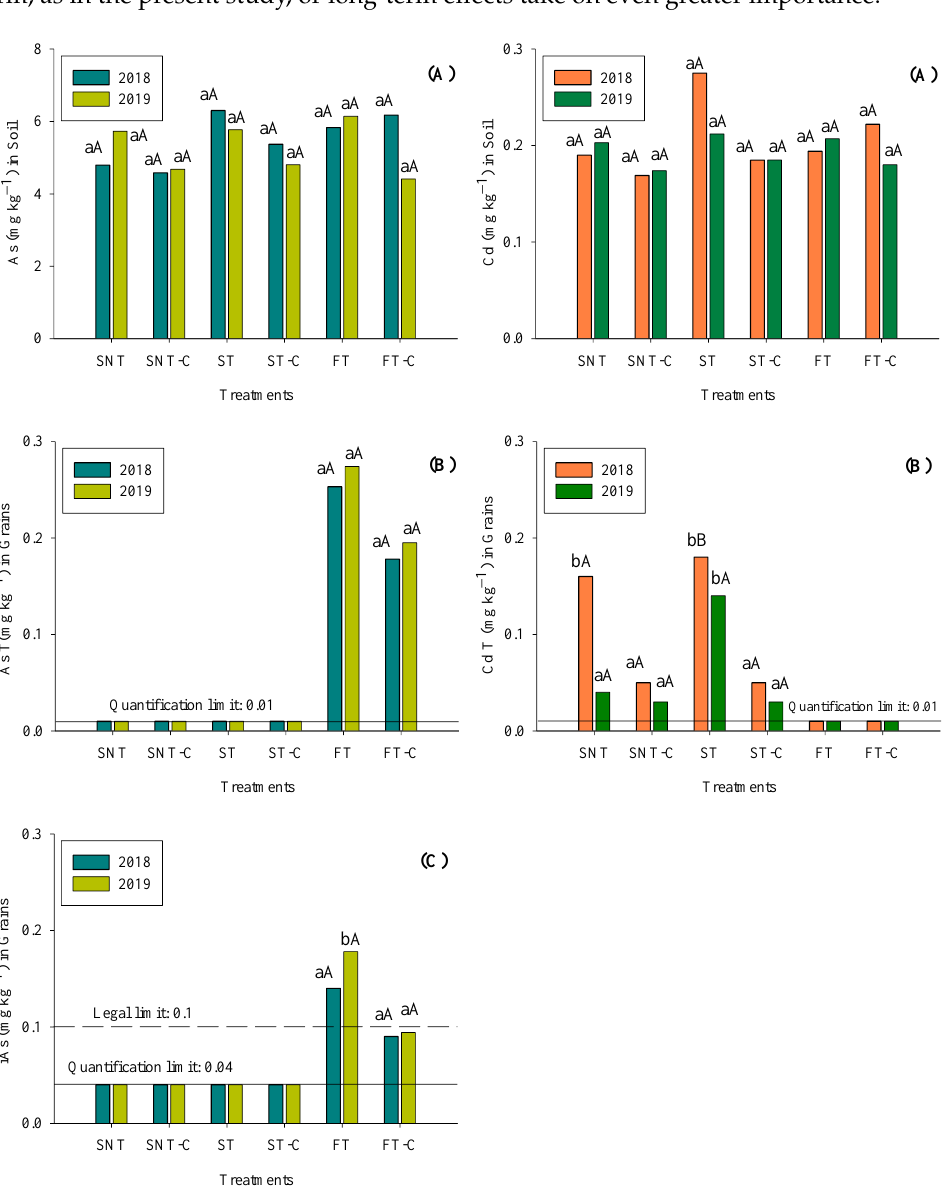
arsenite, which is less strongly adsorbed by soil ferric oxides and more efficiently taken